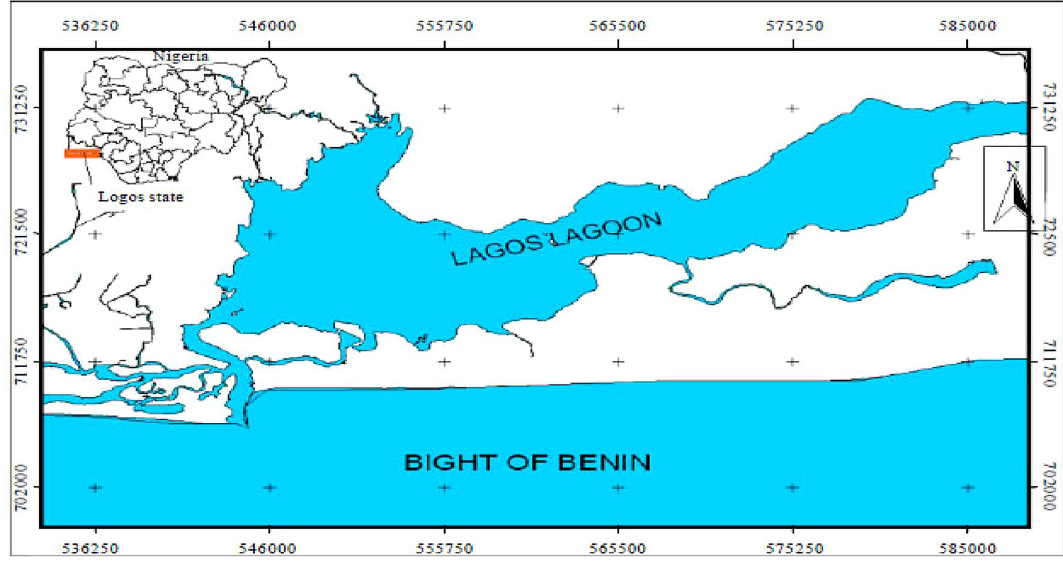
Fig. 1 Map of Lagos Lagoon. Source